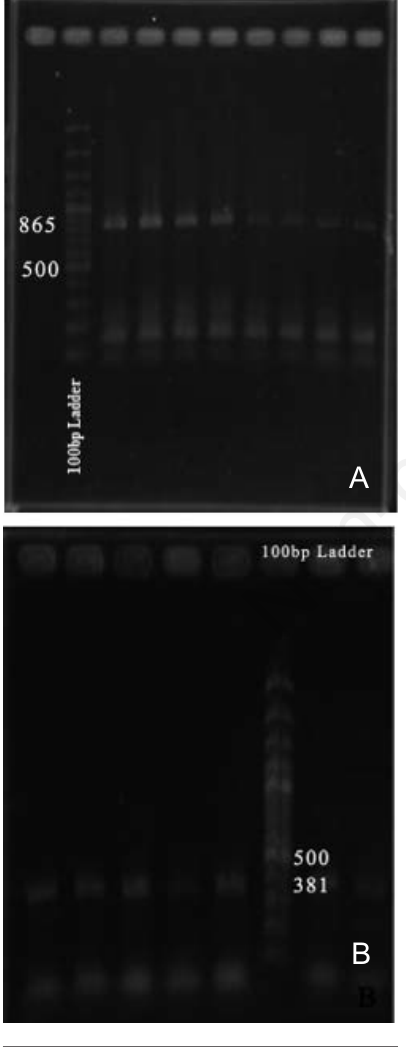
Figure 1. Amplified products with expect- ed sizes. A) 865 bps amplified products, B) 381 bps amplified